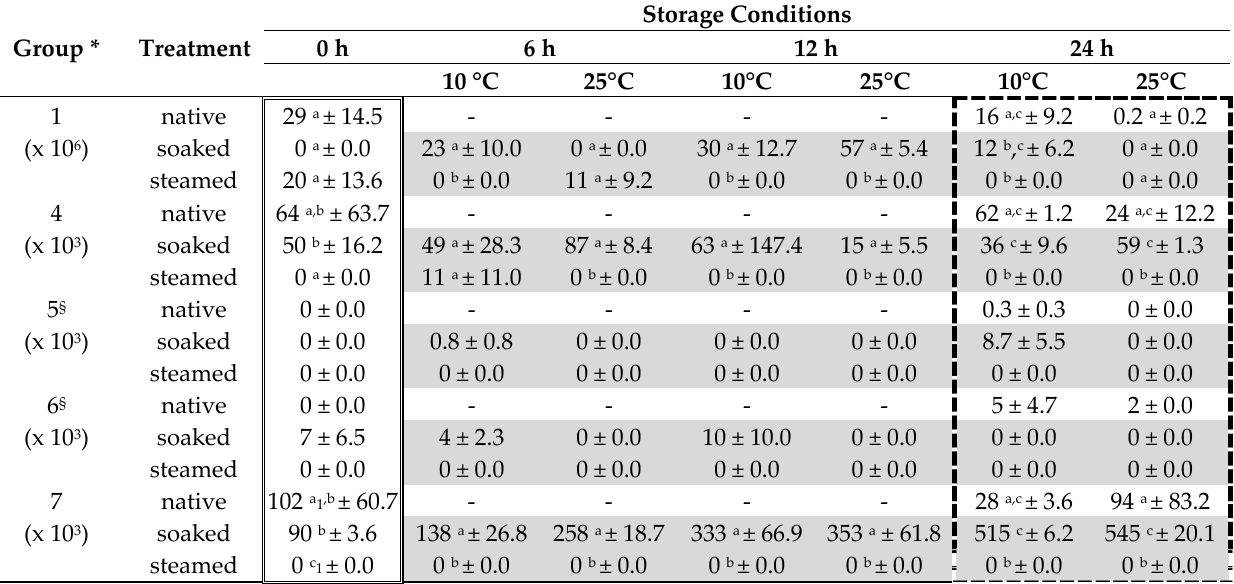
Table 6. Detected microbial counts (in CFU/g; Lsmeans ± SE) in the native and treated hay.